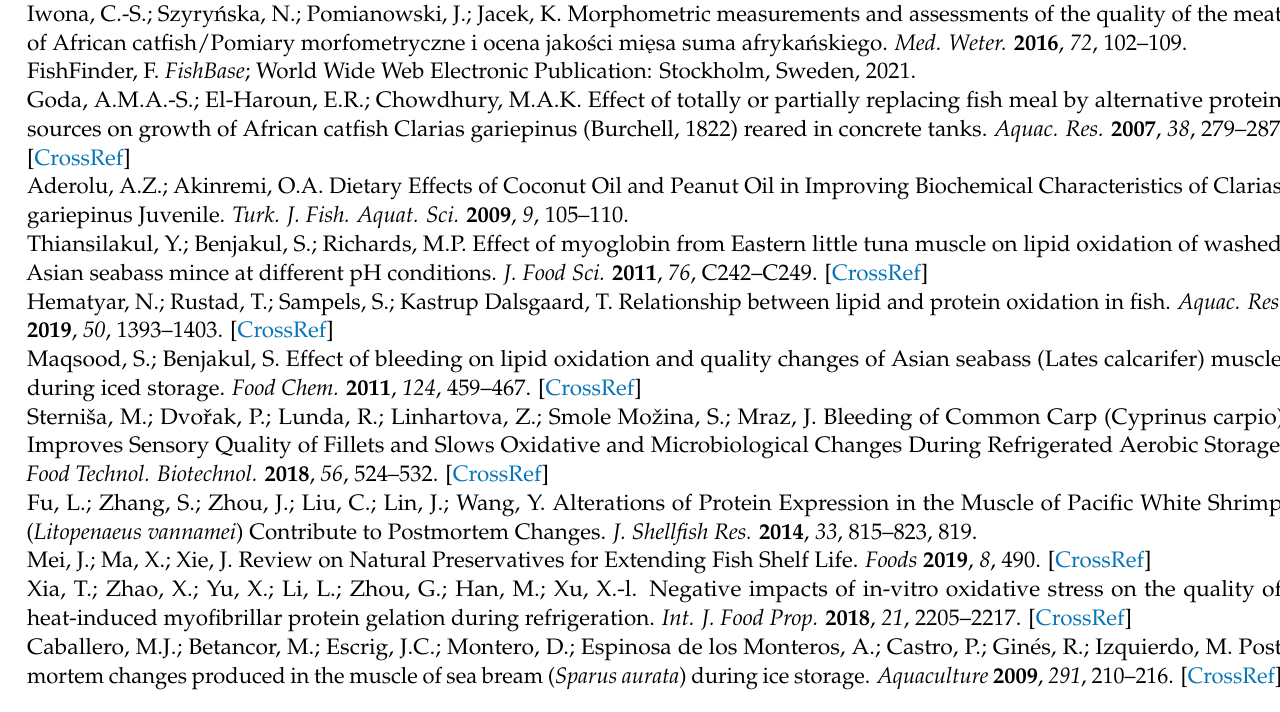
group. Table S2: Three-Way ANOVA p-value table for the data variables. Figure S1. pH. Figure S2. Rigor